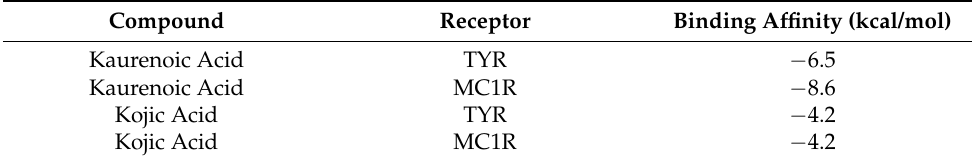
Table 1. The binding affinity results of kaurenoic acid compared to the standard tyrosinase inhibitor kojic